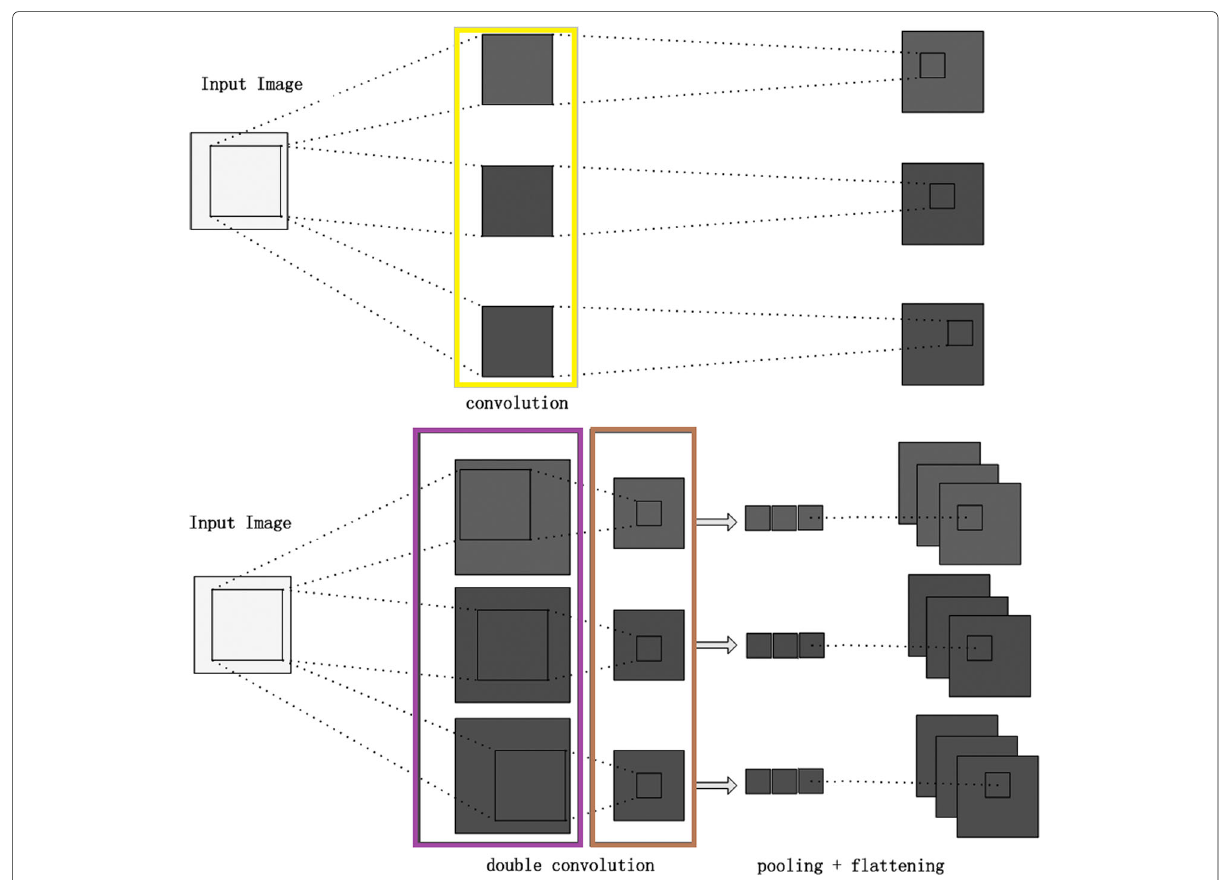
Fig. 6 The structure of a convolutional layer (top) and a doubly convolutional layer (bottom). By adding one extra convolution operation (in the purple rectangle), the independent filters (in the yellow rectangle) are changed into translated versions of each other (in the brown rectangle)